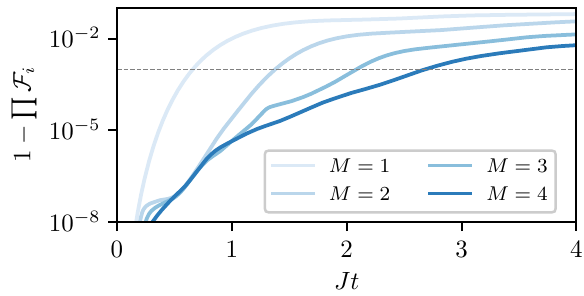
FIG. 11. Approximation error of time evolution algorithm restricted to the quantum circuit ansatz for different M